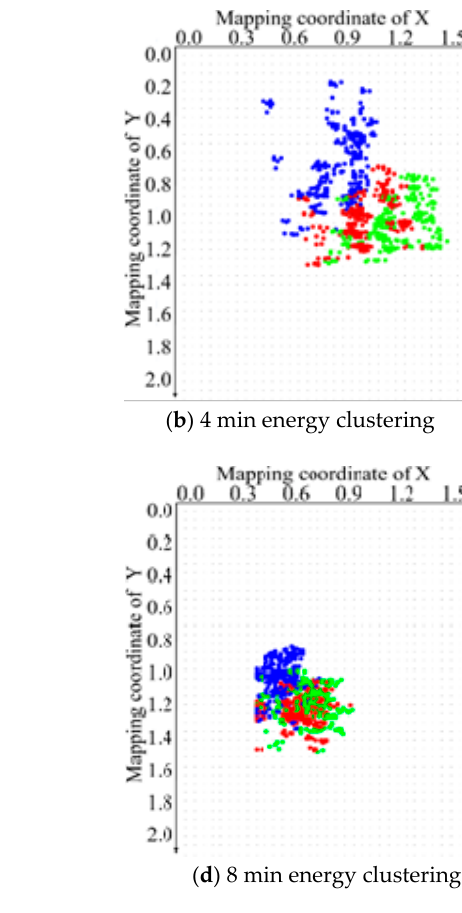
Figure 12. Energy clustering center distributions at different fixation time.